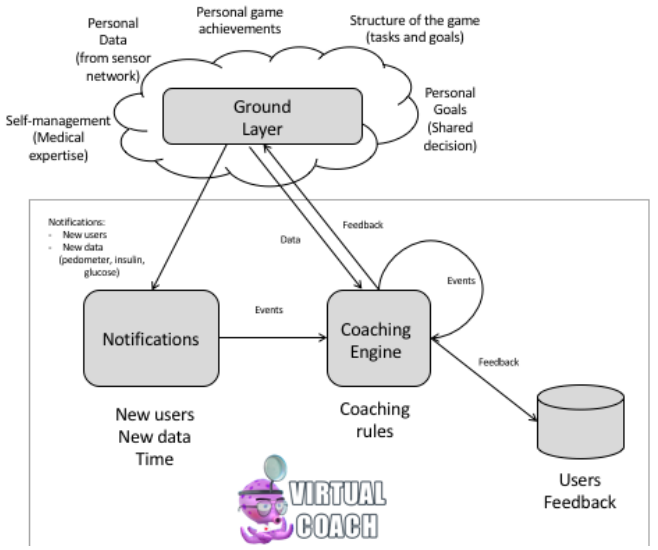
Figure 7. The coaching engine of the Virtual Coach of the PERGAMON platform depicting the knowledge and data source components used by the Virtual Coach.